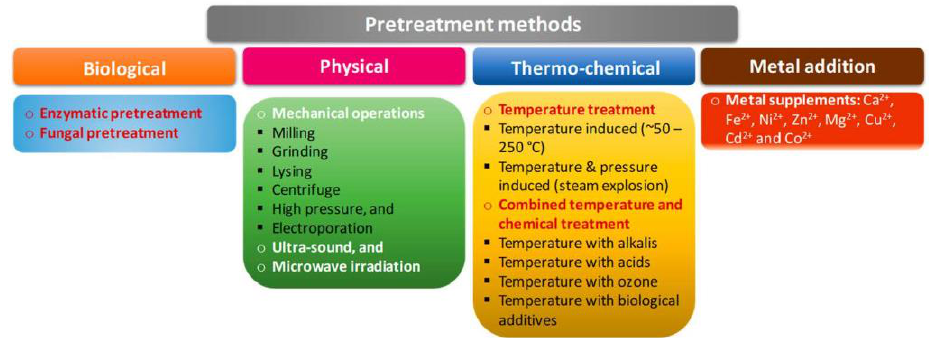
Figure 3. Primary feedstock pretreatment categories — modified from Ref. [65].